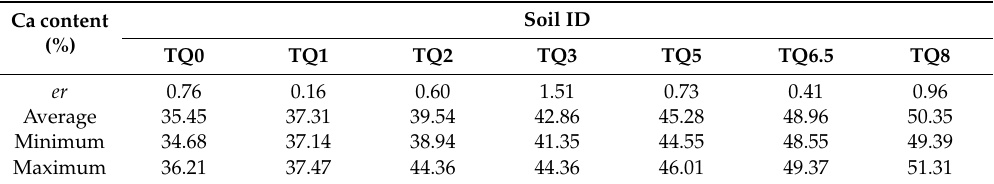
Table 5. EDS analyses of Ca contents on natural soil and treated